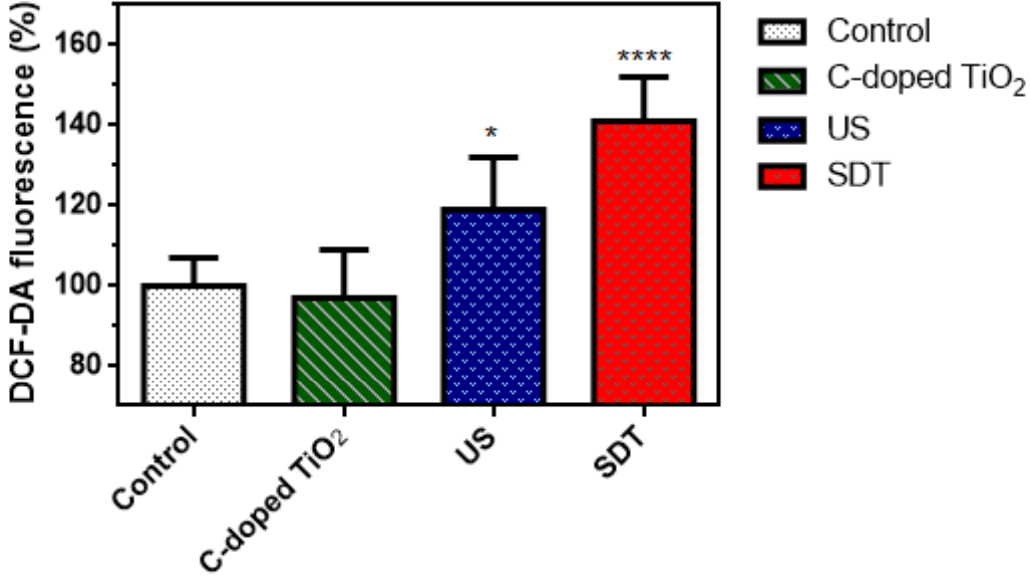
Figure 6. DCFDA test for relative ROS concentration induced by C-doped TiO 2 activated by US (one-way ANOVA, mean ± SD, n = 6, *: p < 0.05, ****: p < 0.0001).